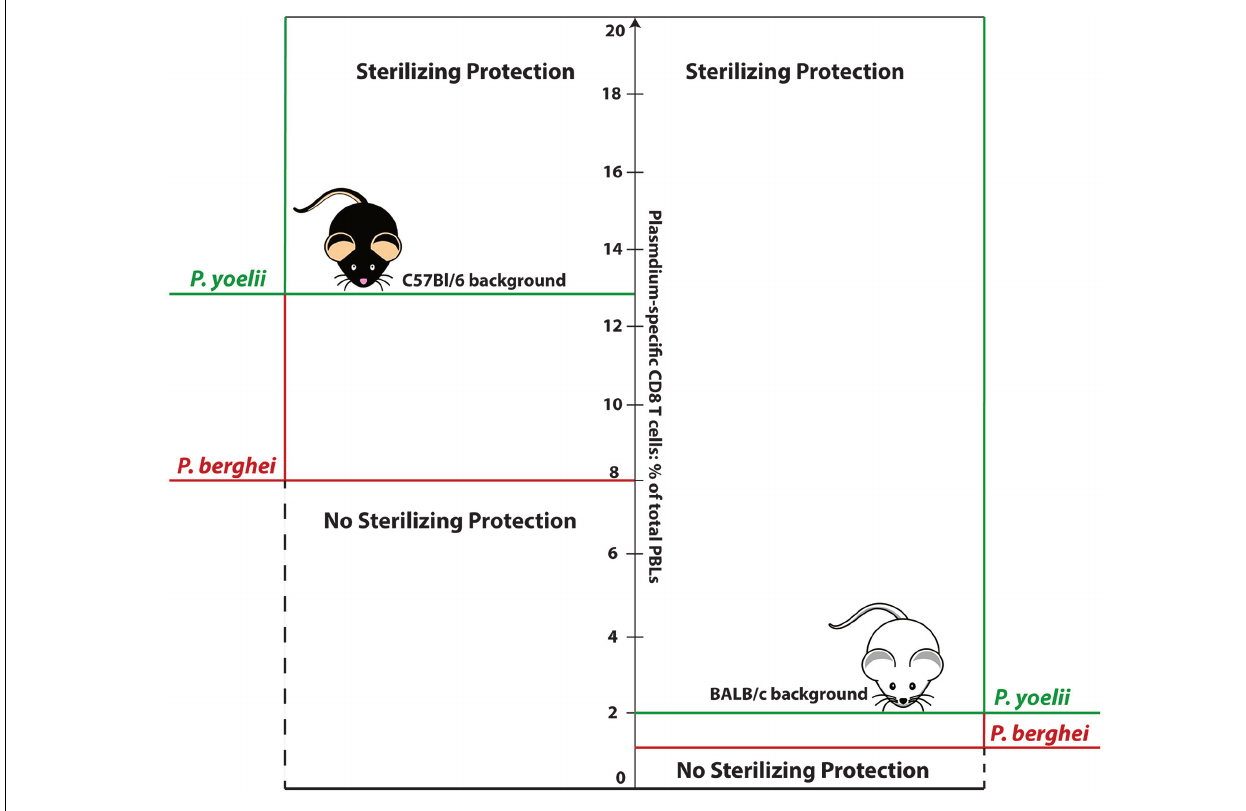
CD8 T-cell equivalent to ∼ 1% or 2% of total PBLs, respectively. Sterilizing protection of mice with C57Bl/6 background requires substantially higher CD8 T-cell numbers: ∼ 8% of total PBLs in the case of P. berghei infection, or ∼ 13% in the case of P. yoelii